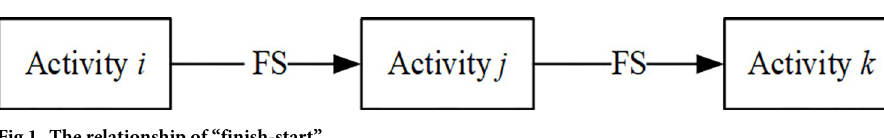
Fig 1. The relationship of “finish-start”.